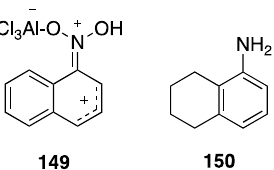
Figure 2. Superelectrophilic activation of 1-nitronaphtalene.